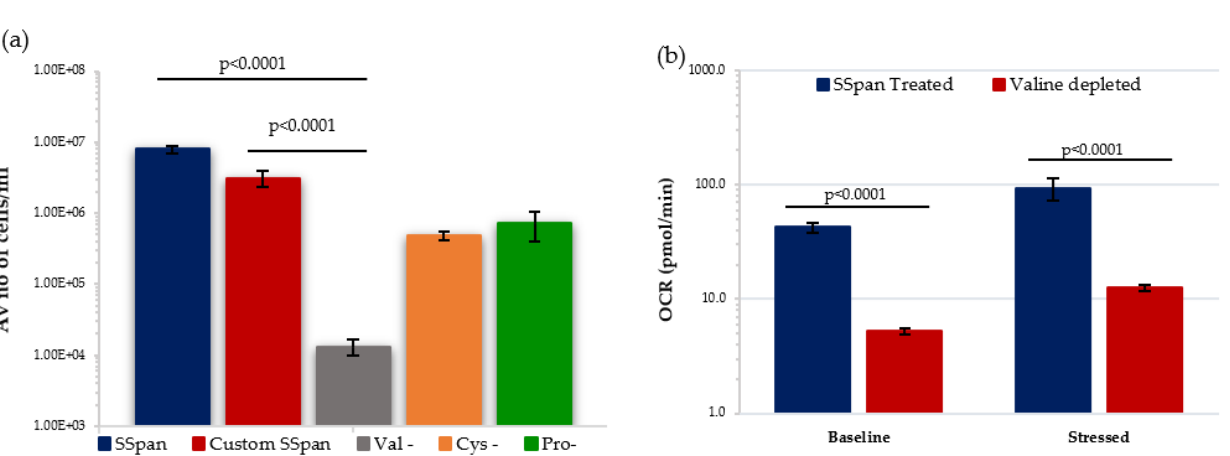
Figure 7. Effect of amino acid depletion on proliferative capability and metabolism of HSPC popu- lation extracted from day 7 expansion cultures under low O 2 . ( a ) Compares the growth of HSPCs treated with different culture conditions ( N = 3; 3 wells/condition/experiment). ( b ) Displays the effect of Valine-deprived media on the metabolic potential of HSPCs under baseline and stressed conditions ( N = 3; 3 wells/condition/experiment). Error bars represent ± SEM. ANOVA and multiple comparison test applied.